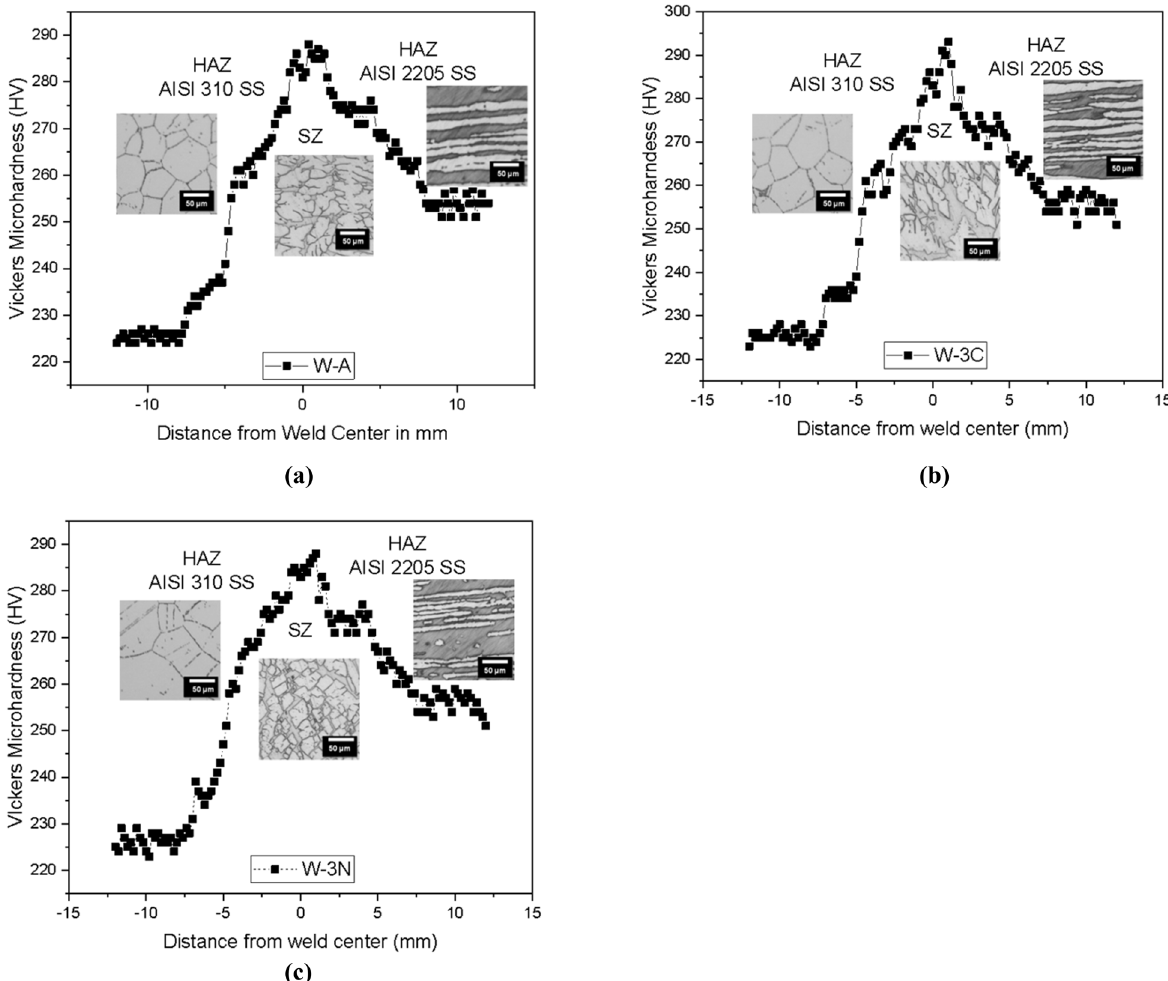
Figure 5: Microhardness variations across the weld. ( a ) Microhardness distribution across W - A, ( b ) microhardness distribution across W - 3C, and ( c ) microhardness distribution across W - 3N.